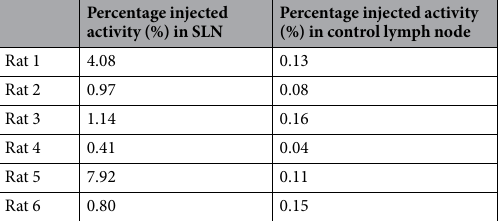
fat capsule. In panel B the total movement, i.e. the movement at all frequencies and with all phases, is overlaid as colour-code on the ultrasound B-mode image. Panel C shows the MMUS image. In this image, only pixels showing displacement with the same frequency and phase ( ± 0.35 radians) as the applied magnetic field are colour-coded and overlaid on the ultrasound B-mode image.